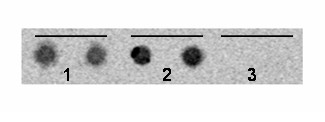
Dot-blot analysis of total tRNA from the yfhQ K.O. strain incubated with YfhQ and AdoMet. The reaction mixture containing 50 mM PIPES-Na, pH 7.0, 4 mM MgCl2, 100 μg of total tRNA from yfhQ K.O. strain, 5 μg of the purified YfhQ protein (1-YfhQ protein purified from the yfhQ K.O. strain transformed with a plasmid carrying the yfhQ gene, 2 – YfhQ purified from the regular overexpressing strain, 3 – a negative control experiment without any protein), and 10 μM [14C-methyl] AdoMet (53 mCi/mmol). After 60 min incubation at 37°C, 50 μl aliquots were filtered in duplicate in a dot-blot manifold (Scie-Plast) using a DE-81 cellulose filter. The filter was washed three times with 200 μl of the reaction buffer and one time with 70% EtOH, dried and exposed to the PhosphorImager screen. The resulting image was scanned on the Storm 820 PhosphorImager.